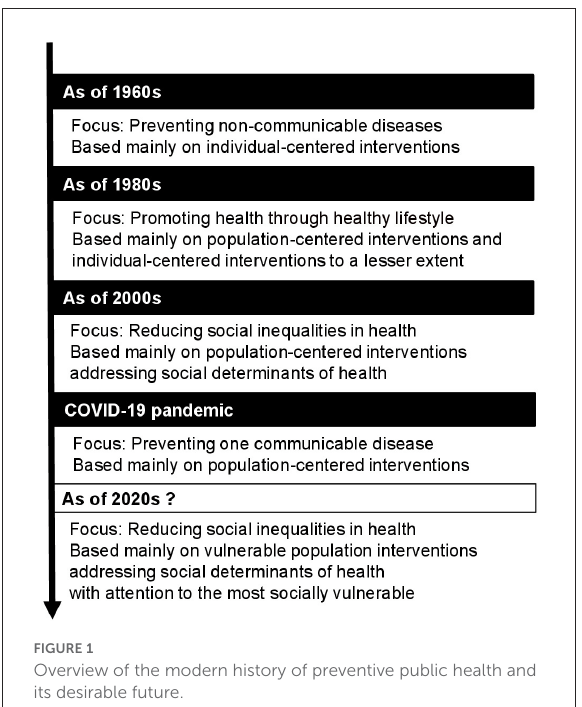
FIGURE1 Overview of the modern history of preventive public health and its desirable future.